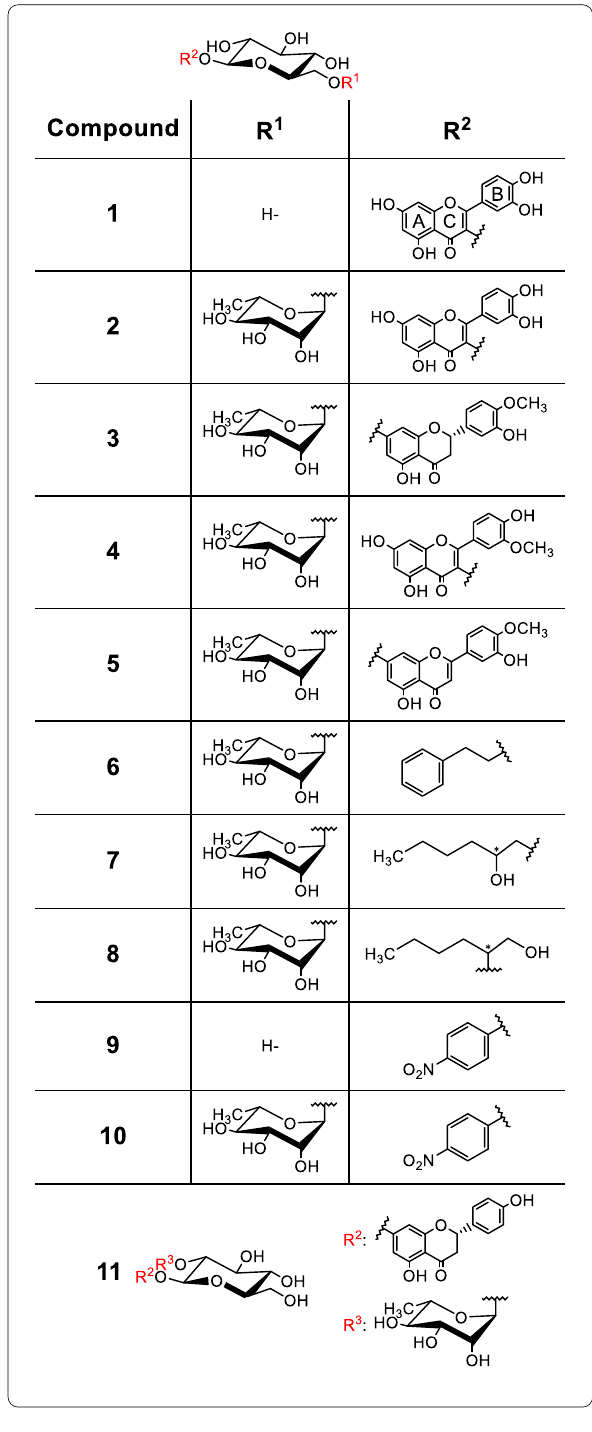
Fig. 1 Chemical structures of selected transglycosylation products and flavonoid glycosides tested as substrates. 1 : isoquercitrin (quercetin 3- O -β- d -glucopyranoside); 2 : rutin (quercetin 3- O -rutinoside); 3 : hesperidin (hesperetin 7- O -rutinoside); 4 : narcissin (isorhamnetin 3- O -rutinoside); 5 : diosmin (diosmetin 7- O -rutinoside); 6 : 2-phenylethyl rutinoside; 7 : hexane-2-ol-1-yl rutinoside; 8 : hexane-1-ol-2-yl rutinoside; 9 : p -nitrophenyl β- d -glucoside; 10 : p -nitrophenyl rutinoside; 11 : naringin (naringenin 7- O